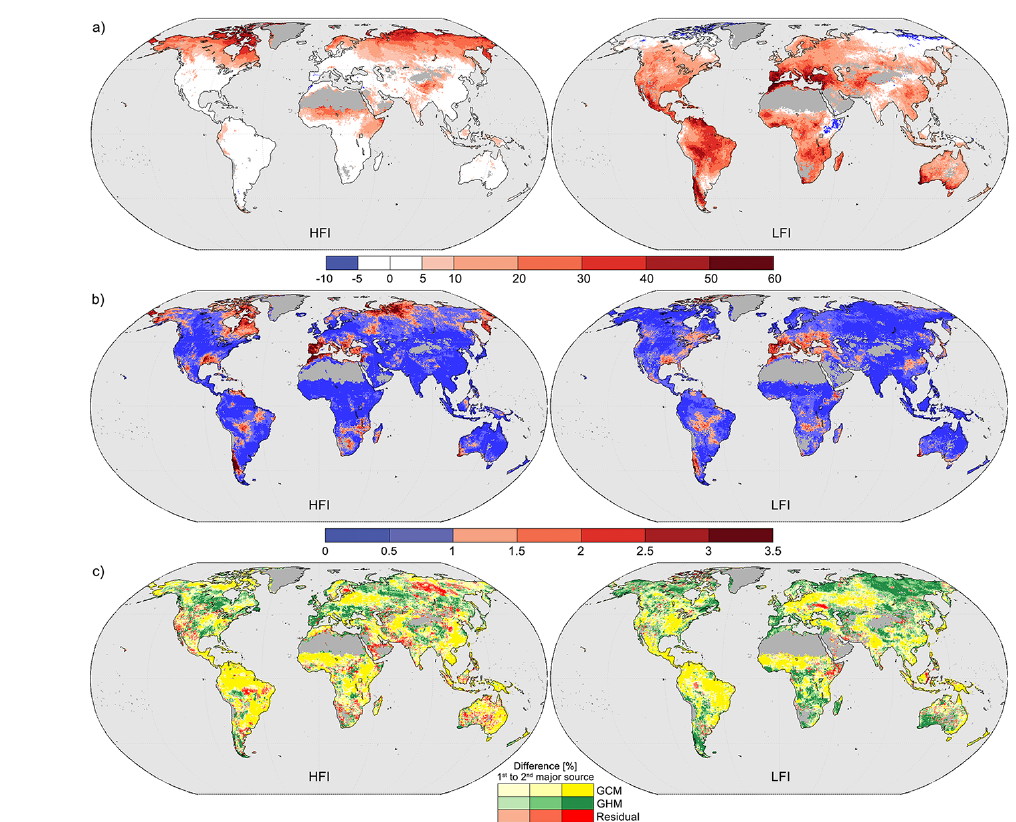
Figure 1. Change in the frequency (in %) of days under high (left) and low (right) flow conditions for the period 2066–2099 relative to 1972–2005, based on a multi-model ensemble (MME) experiment under RCP8.5 from five GCMs and six GHMs: (a) MME mean change and associated (b) signal-to-noise ratio; (c) Proportion of variance per factor for the MME mean change: GCM (yellow), GHM (green), Residual